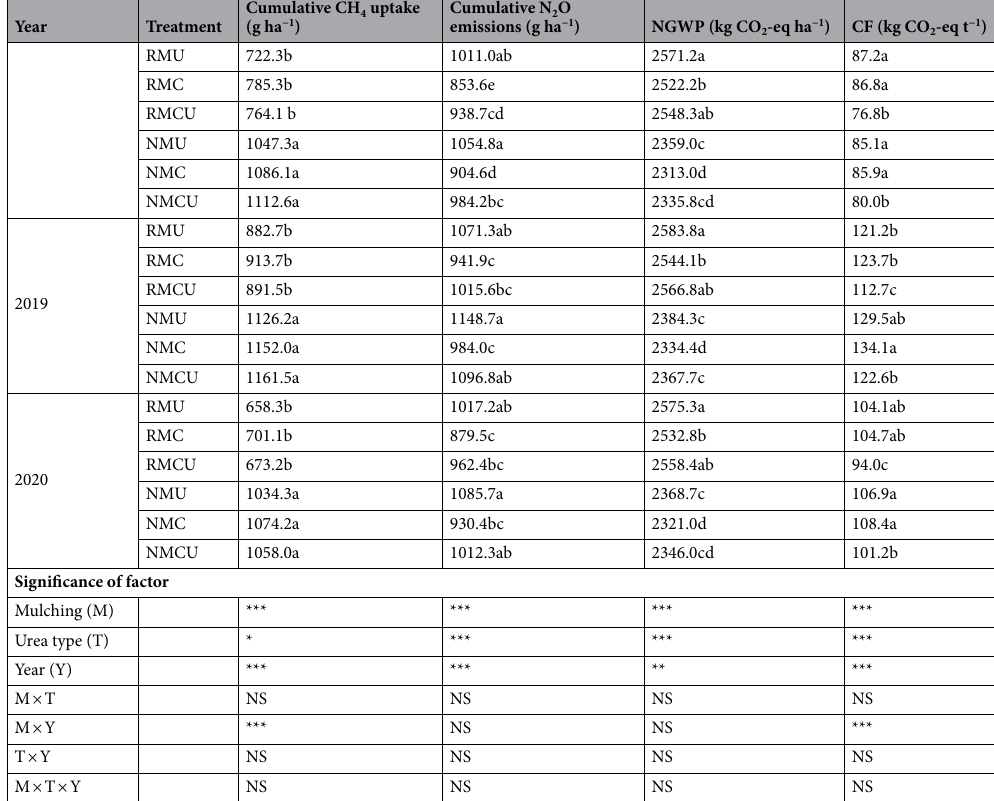
Table 3. Cumulative CH 4 uptake and N 2 O emissions, Net global warming potential (NGWP) and carbon footprint (CF) under different treatments in 2018–2020 growing seasons. RM plastic film mulching, NM no plastic film mulching, U conventional urea, C controlled-release urea, CU a mixture of equal amount of conventional urea and controlled-release urea at 1:1 ratio. Numbers followed by different letters in each column indicate significantly differences at α = 0.05 based on ANOVA test. The statistical significance is denoted by *P ≤ 0.05; **P ≤ 0.01; ***P ≤ 0.001, and NS not